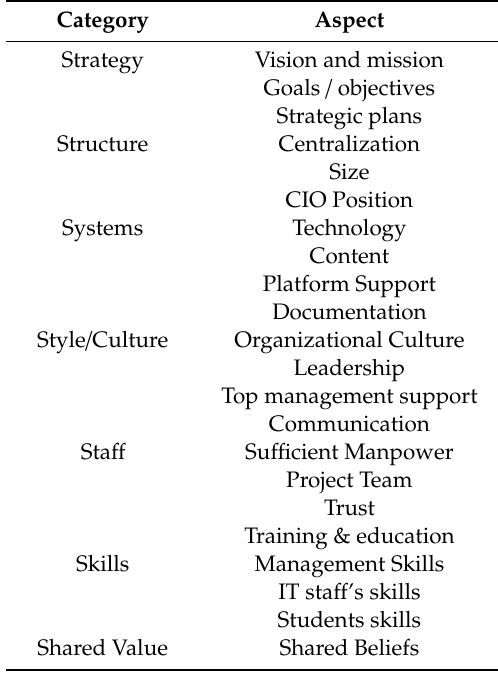
Table 1. Model for e-learning readiness assessment by Alshaher (2013) [7], building upon the seven S model by McKinsey (categories on the left) and Hanafizadeh and Ravasan (2011)